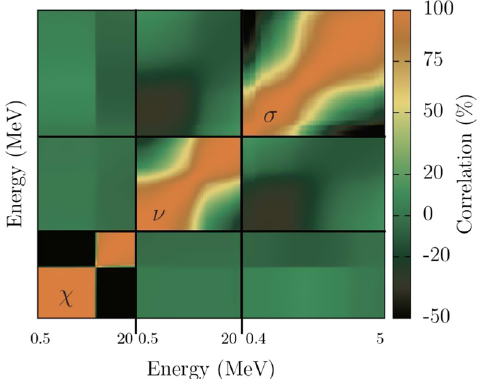
Fig. 1. Posterior correlation matrix for 239 Pu n s f , and x (for the incident neutron energy of 750 keV) observables. The energy axis is for the incident neutron for n and s f , and for the outgoing neutron for x . The axes are in